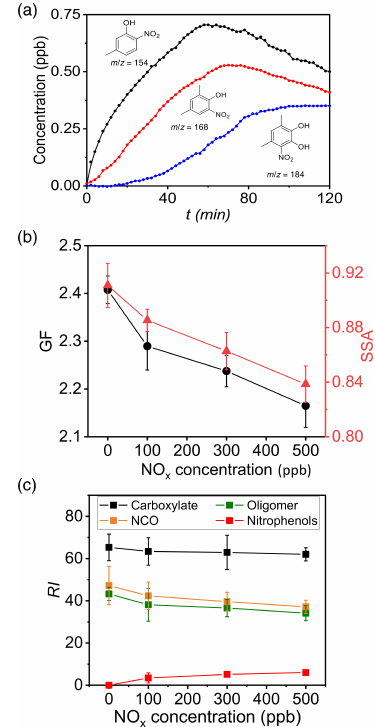
Figure 6. The effects of NO x . (a) Time-dependent gas-phase con- centrations of 5-methyl-2-nitrophenol (black, m/z = 154), dimethyl nitrophenol (red, m/z = 168), and dihydroxy nitrotoluene (blue, m/z = 184). The numbers denote the mass-to-charge ratio ( m/z ). Initiation of photooxidation by ultraviolet light occurred at t = 0. (b) GF (black) and SSA (red) at 120min with varying NO x concen- tration from 0 to 500ppb. (h) Dependence of aerosol-phase relative mass intensities (RI) for carboxylates (black), oligomers (green), NCOs (brown), and nitrophenols (red) on NO x concentration for (NH 4 ) 2 SO 4 seed particles with 19ppb NH 3 at RH = 70%. The er- ror bar denotes 1 σ of three replicated